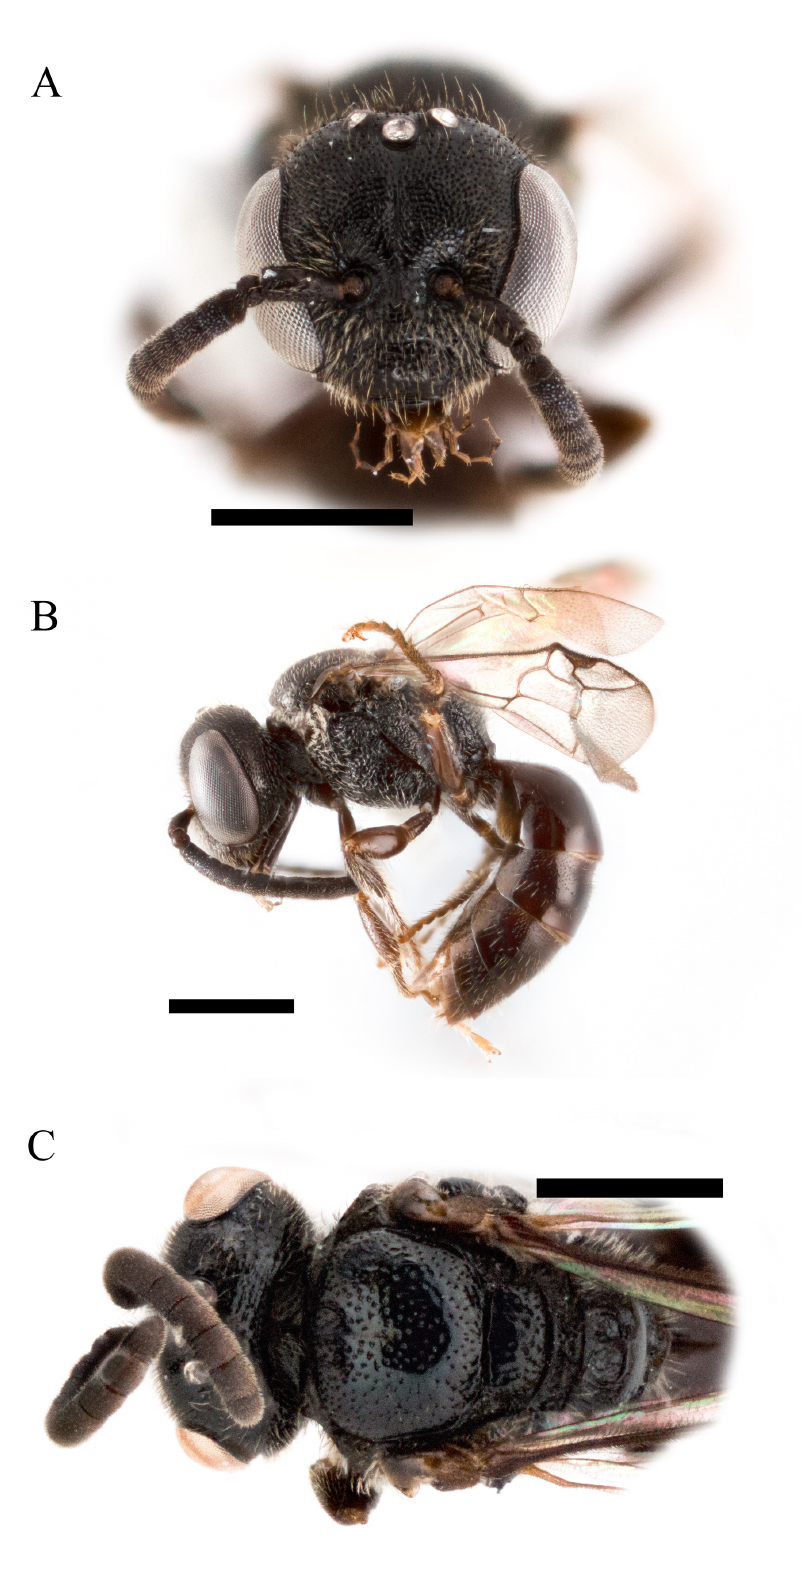
Fig. 9. Sphecodes diablotinus sp. nov. Holotype (A–B) and paratype (C), ♂♂. A . Face. B . Lateral habitus. C . Dorsum of mesosoma. Scale bars = 1